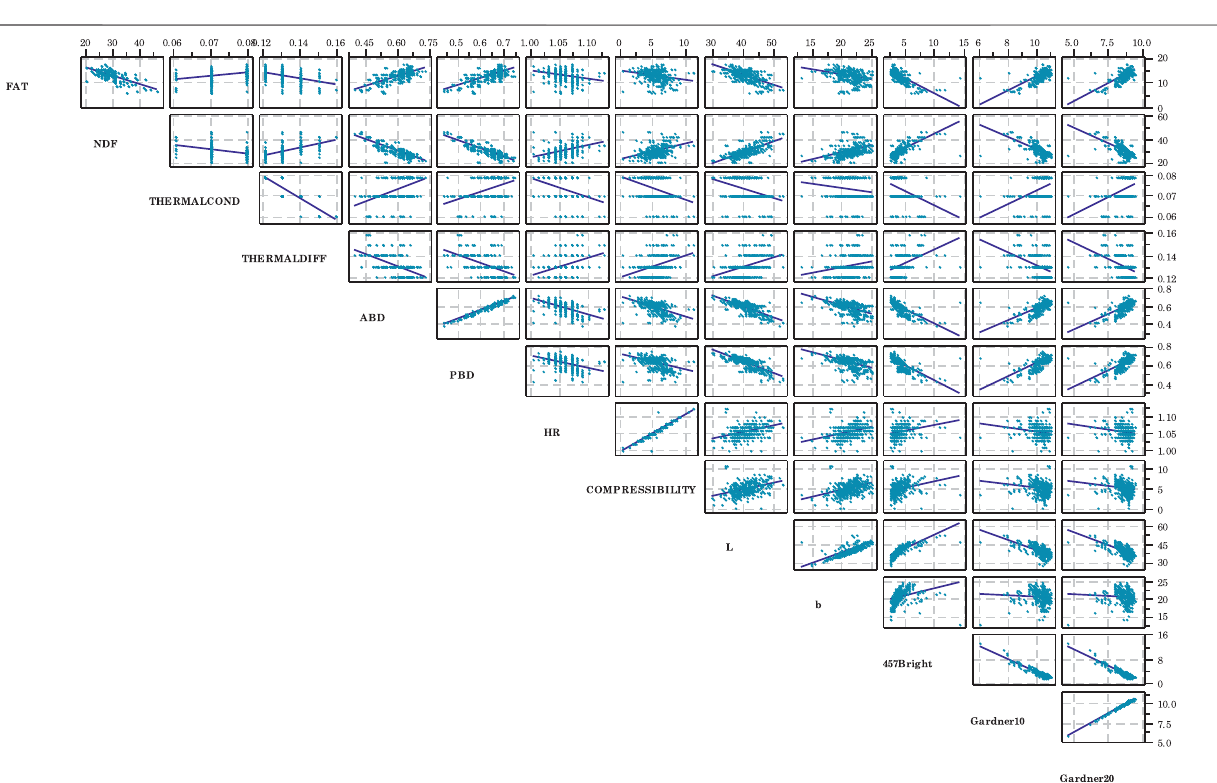
FIGURE 5 | Scatterplot matrix for those variables which exhibited signi fi cant linear correlations. Many variables appear to have strong relationships. Variable de fi nitions provided in Tables 1, 2 .